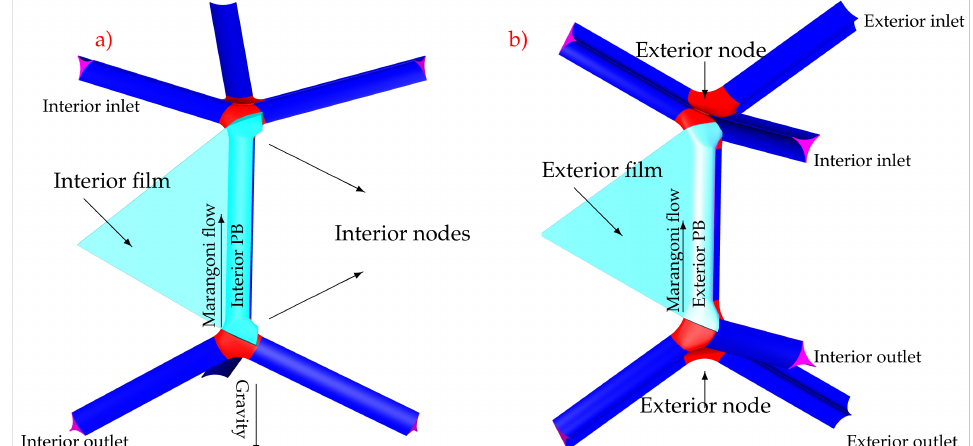
Figure 1. Geometry of the ( a ) Interior foam, ( b ) Exterior foam including two red-colored nodes and one blue-colored interior PB, and an interior film. Inlets/outlets are represented by the pink colors. The exterior nodes are made up of a conjunction of three exterior PBs with an angle of 120 ○ , where two PBs are attached to the wall, with one being perpendicular to the wall. In both geometries, the flow enters from the top of three PB inlets and exits from the three outlets at the bottom. In both geometries, the direction of the gravity force (in the z direction of a coordinate system) is assumed in the opposite direction of the Marangoni flow, which is shown in the interior geometry ( a